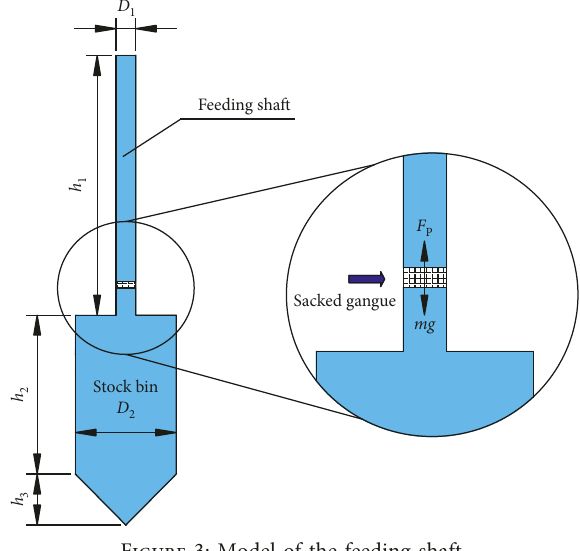
Figure 3: Model of the feeding